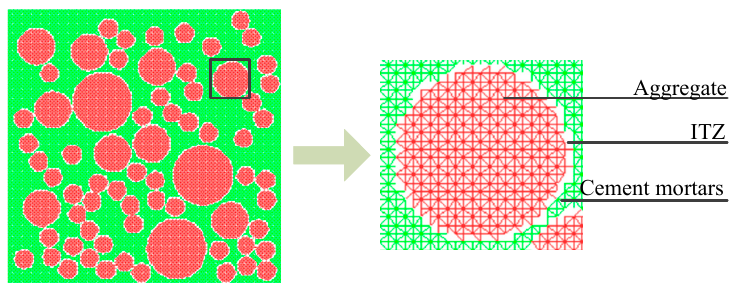
Figure 5. The diagram of mesh generation.